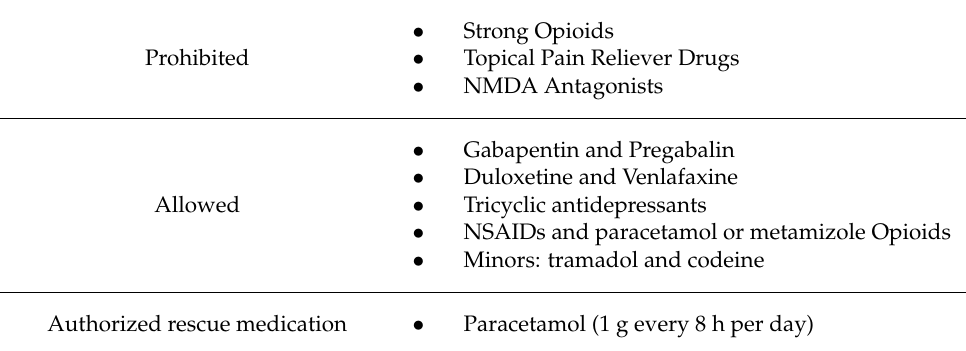
Table 2. Allowed and prohibited medications during the